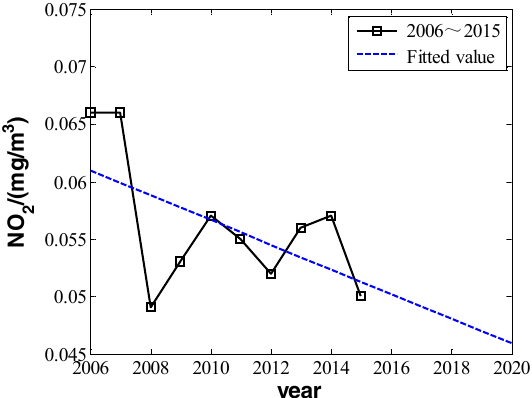
Figure 7. The actual value and predicted value of nitrogen dioxide’s annual daily mean in 2006 to